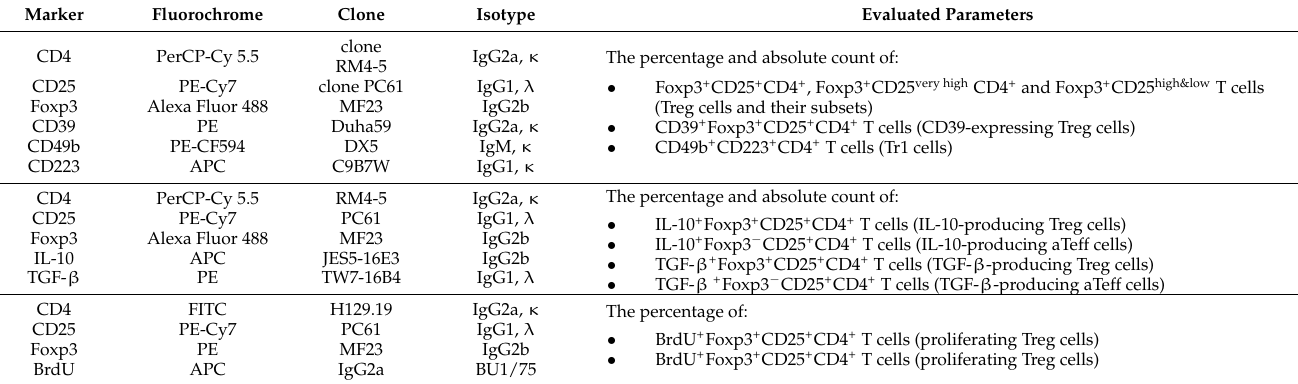
Table 1. The staining combinations, characteristics of monoclonal antibodies and evaluated